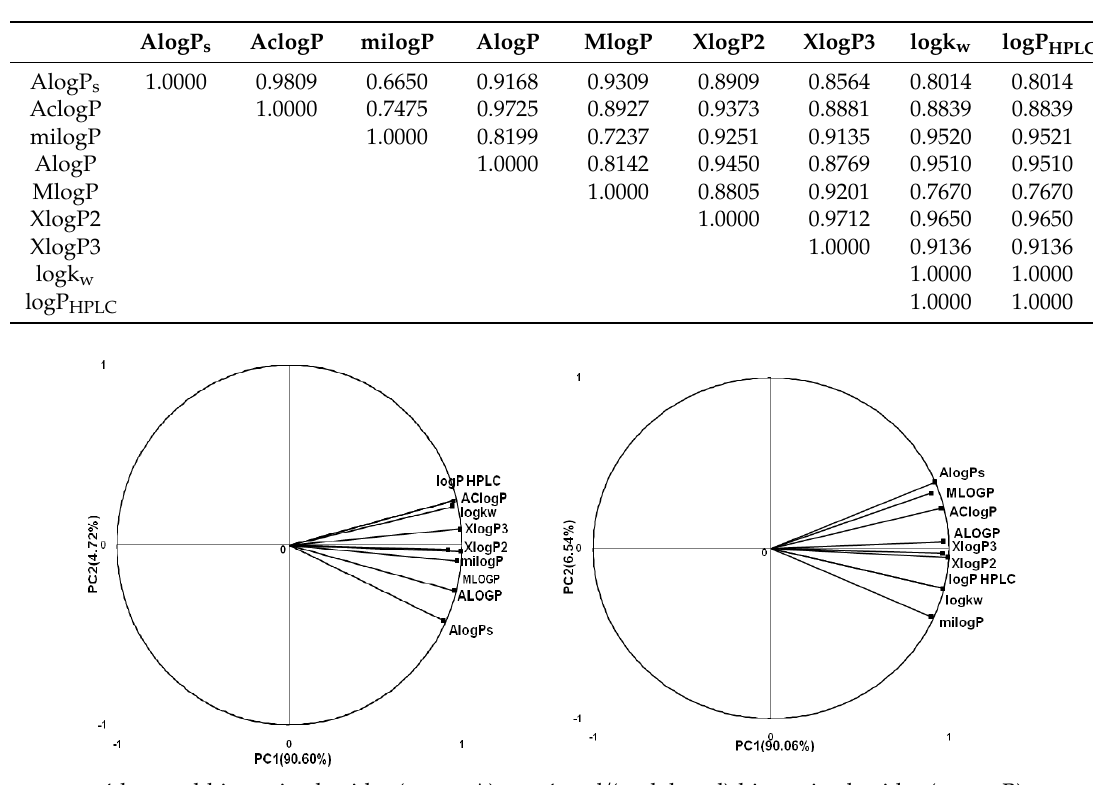
Table 4. The correlation matrix for logP calc vs. logP HPLC (group B: 4-aryl/(cyclohexyl)thiosemicarbazides).